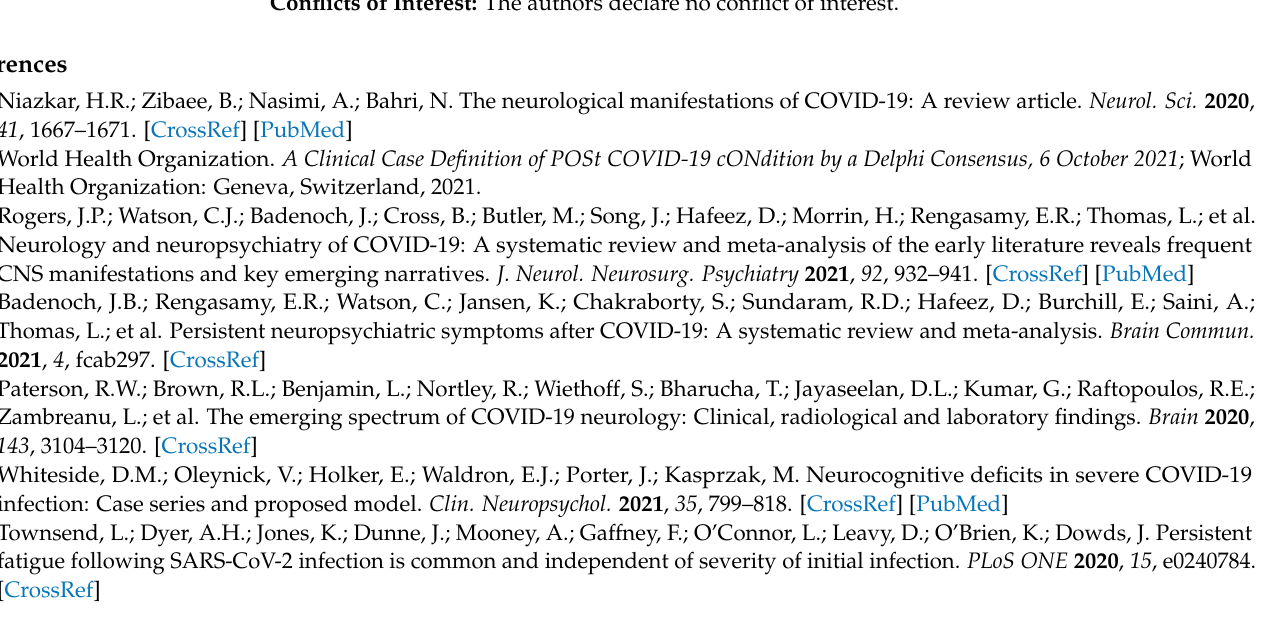
Table S2: Mean age difference between studies with hospitalized patients with (severe) and without (intermed) mechanical ventilation. Figure S1: Descriptive plot of mean age difference between studies with hospitalized patients with (severe) and without (intermed) mechanical